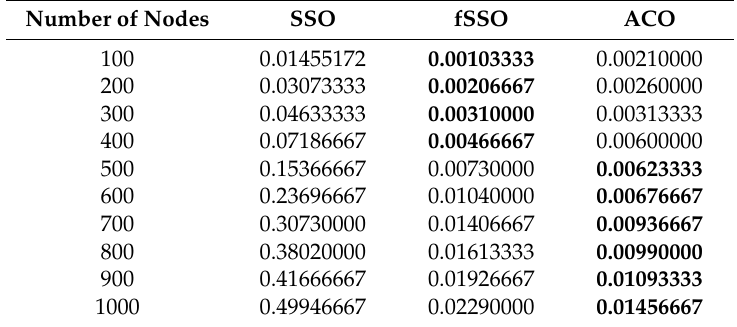
Table 18. Average of running time of fSSO compared with SSO and ACO for ten benchmarks.